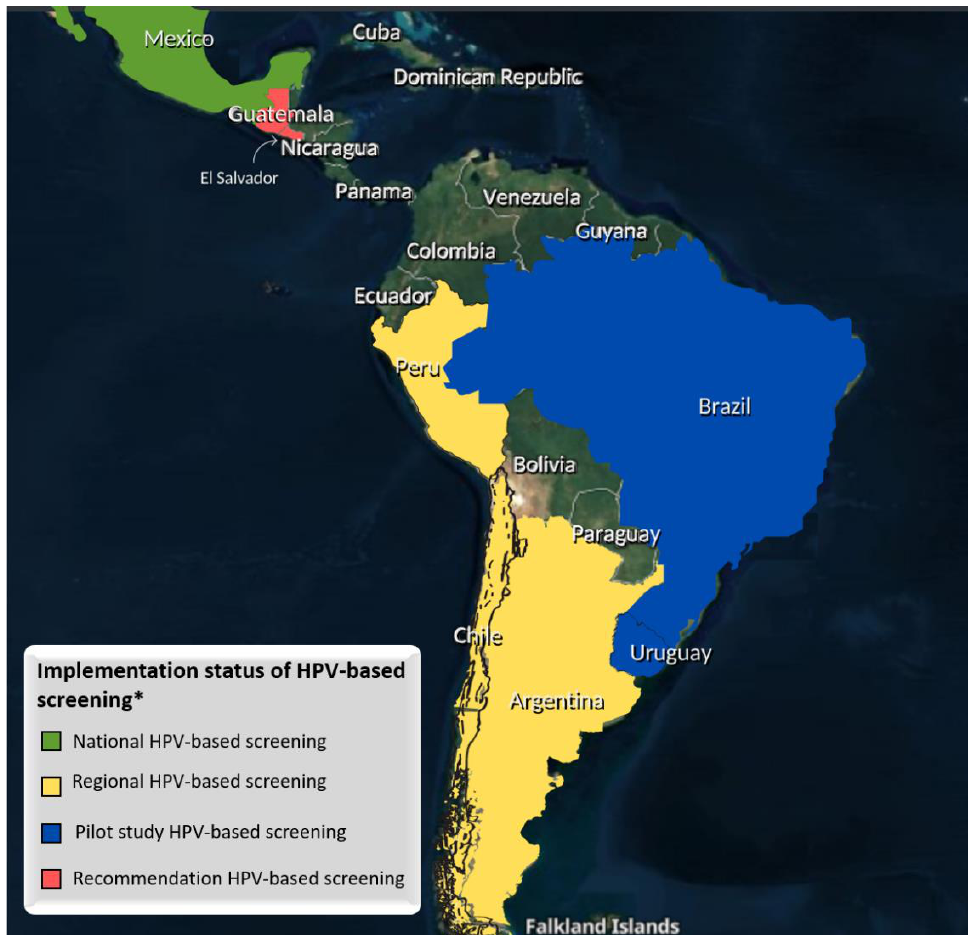
Figure 1. Implementation status of HPV-based screening in Latin American countries. * Countries with information available online.